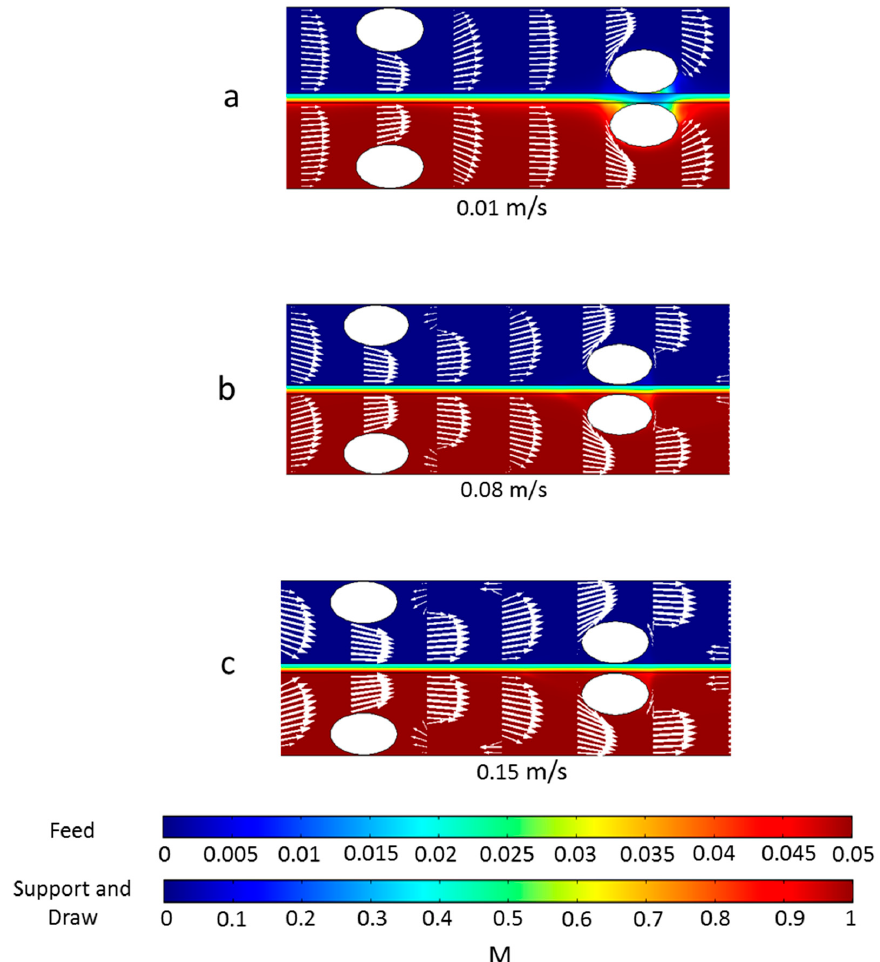
Figure 6. Concentration profile (indicated by the color flood) and velocity profile (indicated by the arrows) under different inlet velocities: ( a ) 0.01 m/s, ( b ) 0.08 m/s, and ( c ) 0.15 m/s. These spacers have a center-to-center filament distance of 6 mm. The size of the arrows is proportional to the logarithmic value of the velocity in order to better show vortices. Data are from the section whose distance from the entrance is approximately 14.5 to 20.5 mm.